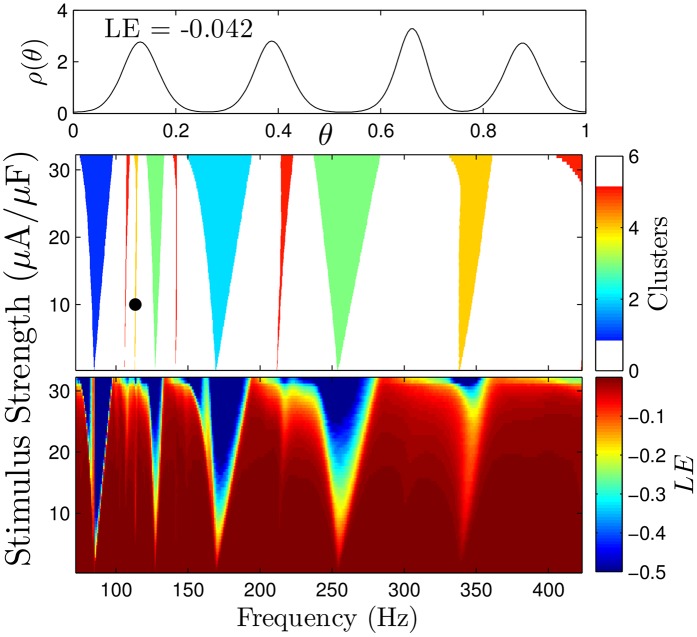
Clustering and Lyapunov exponent calculations for the Hodgkin-Huxley network.The middle panel gives regions of parameter space where clustered desynchronization is guaranteed to occur for small enough noise. The bottom panel shows the average Lyapunov exponent for the steady state distribution. The top panel shows the steady state probability distribution for stimulus parameters shown with black dots in the middle panel.